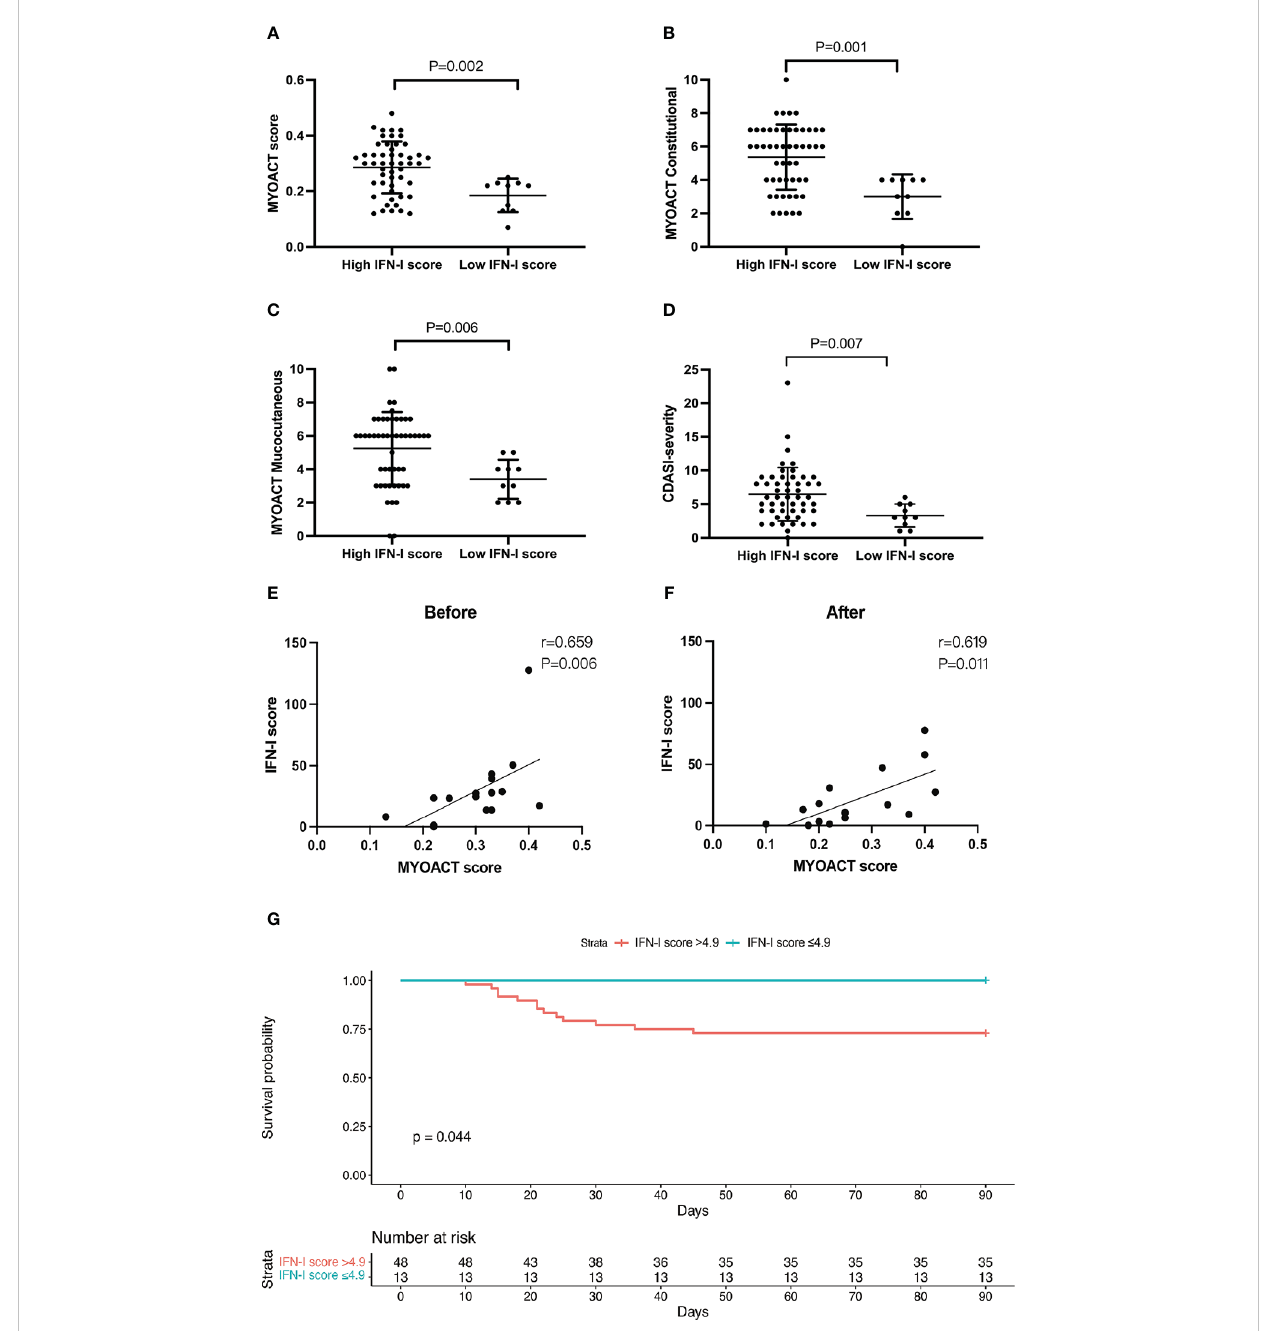
FIGURE 5 A high IFN-I score identi fi es patients with active anti-MDA5+ DM and predicts mortality. Grouped analysis of MYOACT scores and CDASI scores at baseline (A – F) , (A) MYOACT score, (B) MYOACT constitutional, (C) MYOACT mucocutaneous, and (D) severity based on the CDASI. Patients were divided into two groups based on the IFN-I score (high vs . low). Comparisons were performed using the Mann – Whitney U test. (E, F) Correlations of the IFN-I score and the MYOACT score in 16 patients before and after treatment. (G) The Kaplan – Meier survival curve shows the survival rates strati fi ed according to the IFN-I score. The high IFN-I score group had an IFN-I score of >4.9 (n = 48), whereas the low IFN-I score group had an IFN-I score of ≤ 4.9 (n = 13). Comparisons were performed using the log-rank